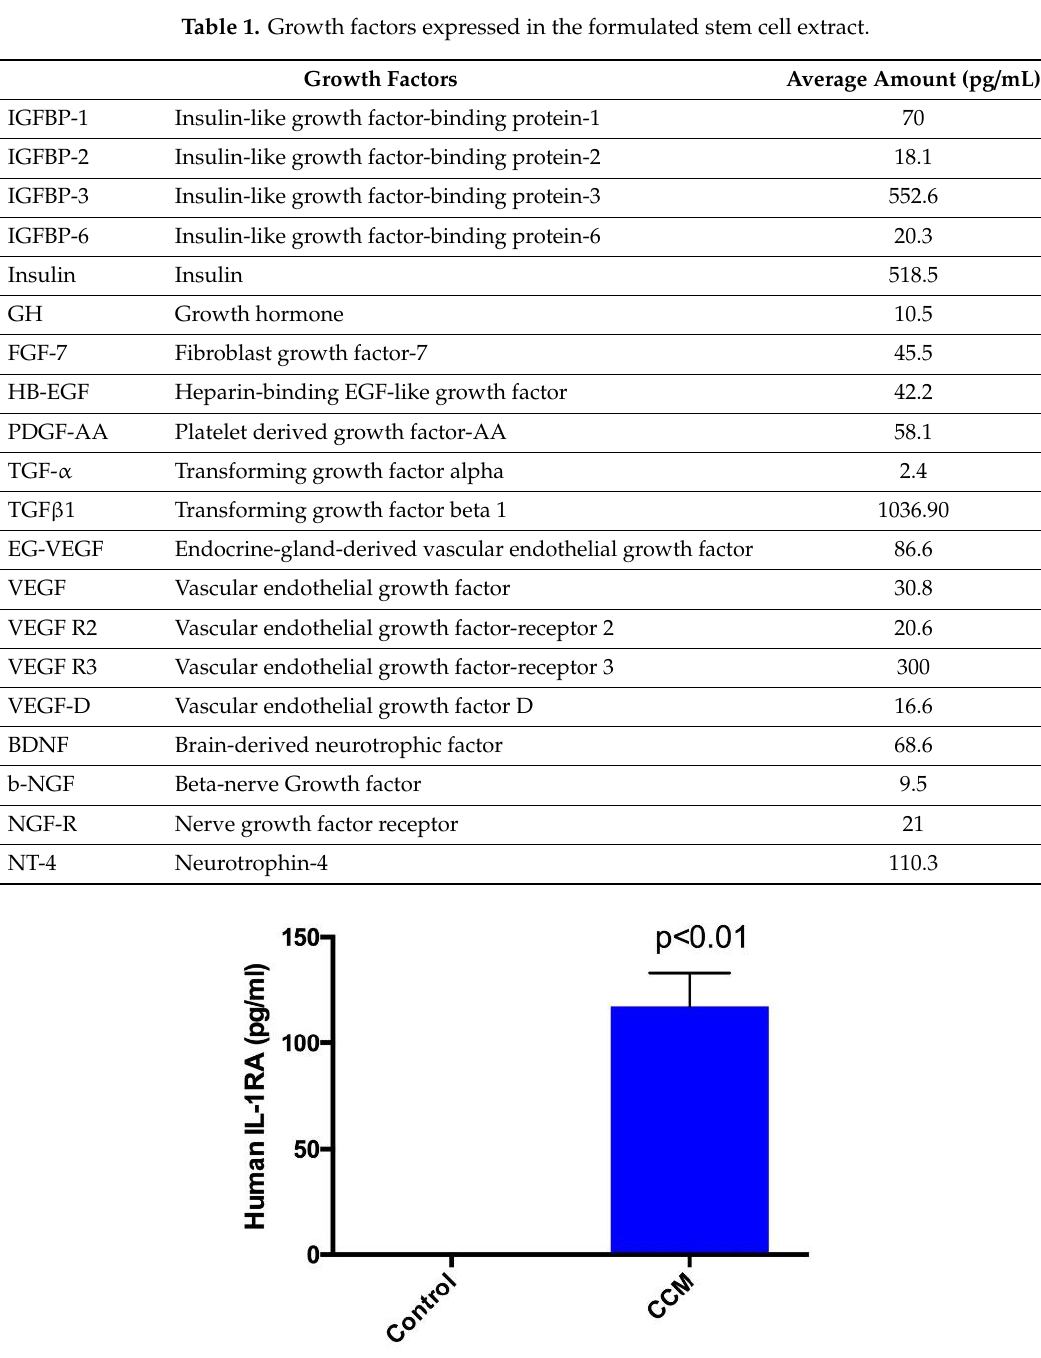
Table 1. Growth factors expressed in the formulated stem cell extract.